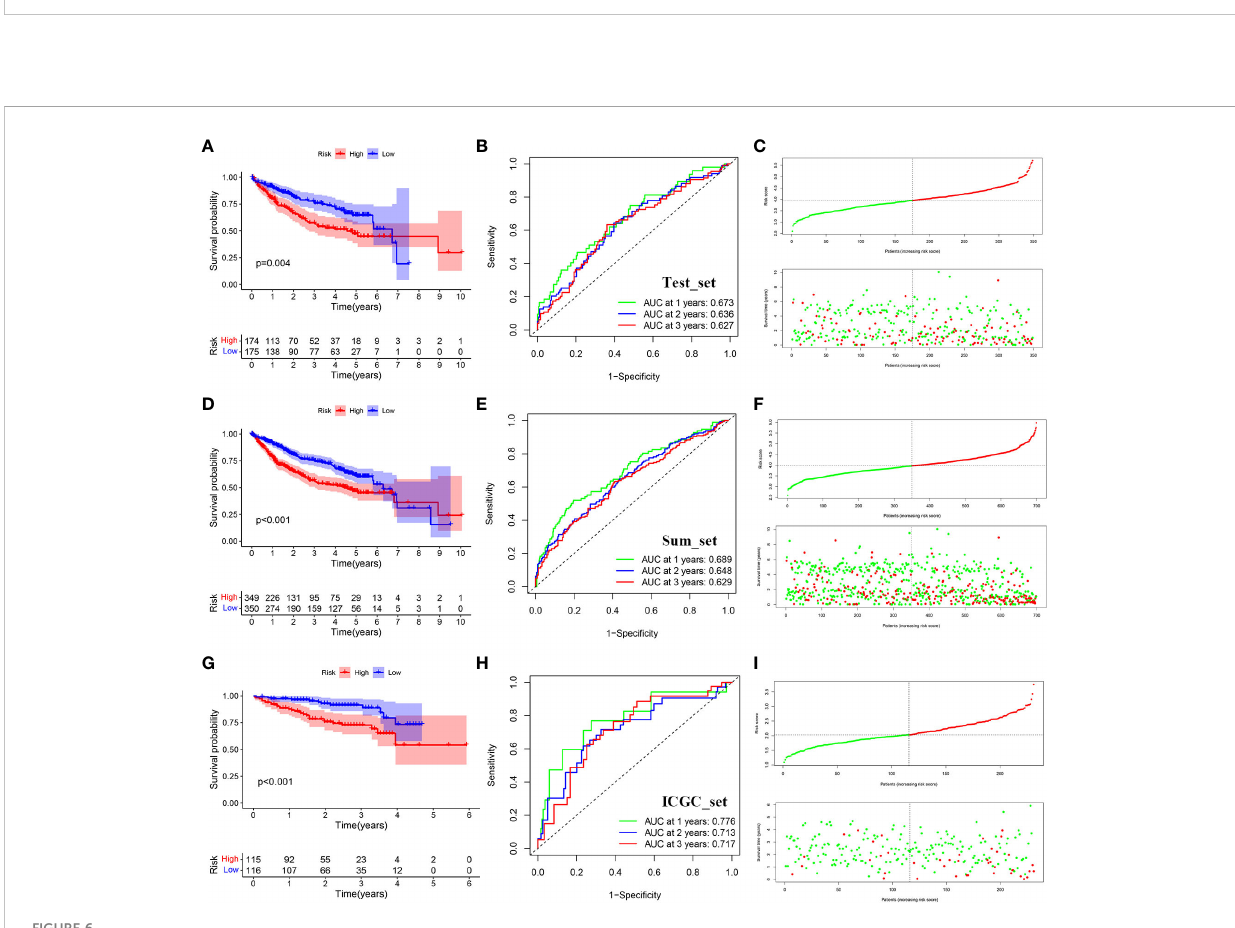
FIGURE 6 Distribution of survival analysis, ROC and risk scores and survival outcomes for the validation set. (A) Survival analysis between the high and low risk groups in TCGA-test. (B) Receiver operating characteristic curve (ROC) of risk score in TCGA-test. (C) Distribution of risk scores and survival outcomes in TCGA-test. (D) Survival analysis between the high and low risk groups in TCGA-sum. (E) Receiver operating characteristic curve (ROC) of risk score in TCGA-sum. (F) Distribution of risk scores and survival outcomes in TCGA-sum. (G) Survival analysis between the high and low risk groups in ICGC. (H) Receiver operating characteristic curve (ROC) of risk score in ICGC. (I) Distribution of risk scores and survival outcomes in ICGC.